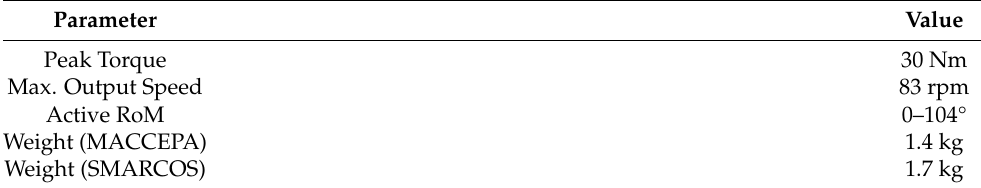
Table 3. Specifications of the